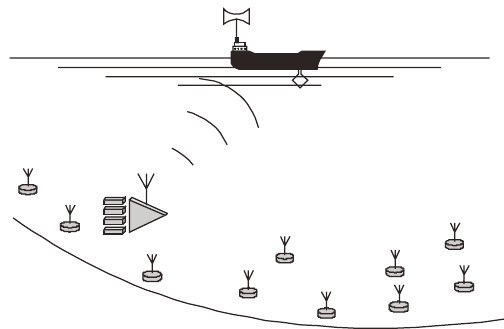
Figure 1: Underwater acoustic sensor networks